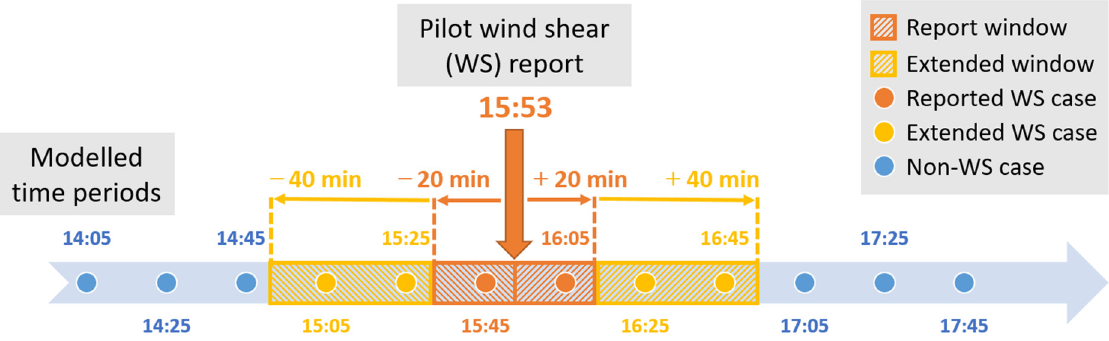
Figure 2. Example assignment of wind-shear event time (upper value, 15:53) to modelling period (lower values, 05, 25, and 45 past the hour), with reported and extended time windows.